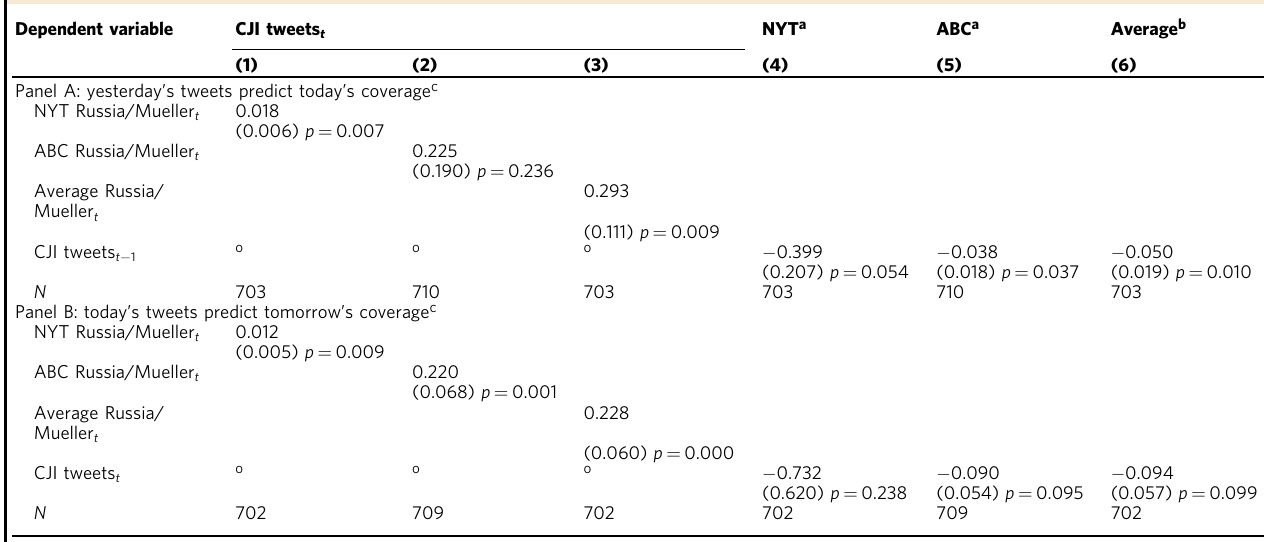
a Coverage of Russia-Mueller on day t (panel A) or day t + 1 (panel B). b Average of the standardized values of coverage of NYT and ABC. c Each model included control variables for each week during the sampling period and long-term time trends as well as the appropriate number of lagged observations for the dependent variable (see “ Methods ” ). Table entries are coef fi cients (standard errors). o Lagged predictor is shown only when of